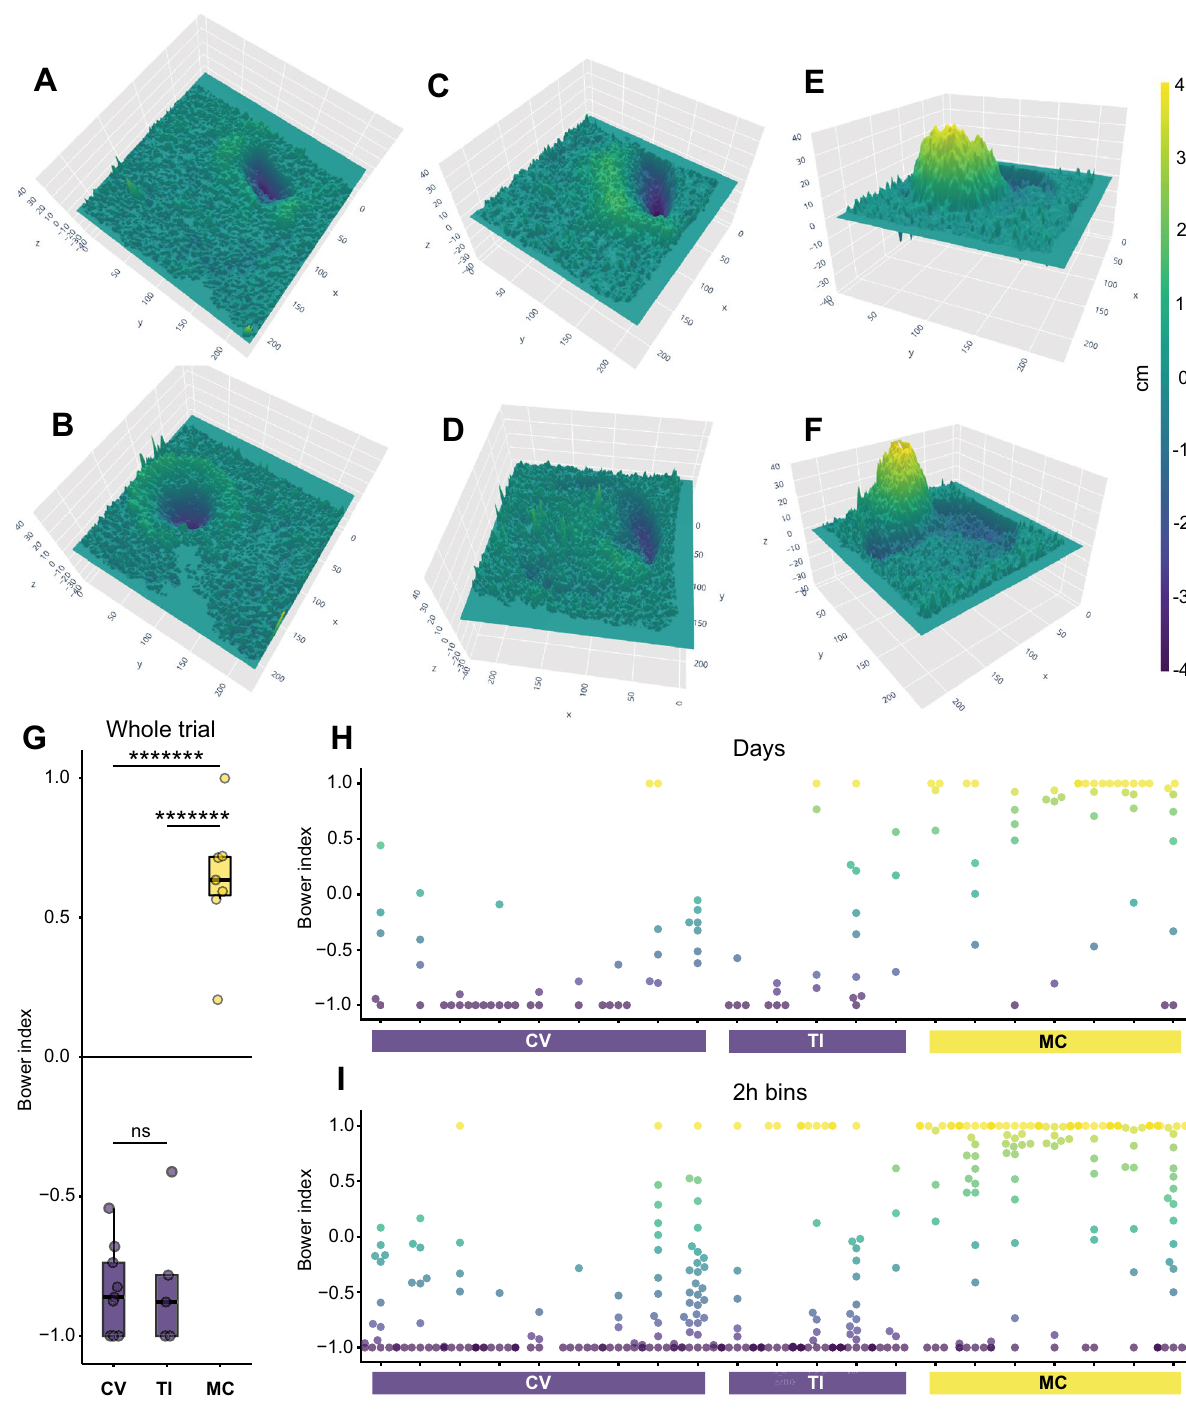
Figure 3. Depth sensing reveals natural species differences in bower construction at multiple timescales. Representative 3D reconstructions show pits constructed by Copadichromis virginalis (CV, n = 9; ( A , B )), pits constructed by Tramitichromis intermedius (TI, n = 5; ( C , D )), and castles by Mchenga conophoros (MC, n = 7; ( E , F )); all z-axes amplified for visual effect). The Bower Index, a measure of the directional bias in bower construction, revealed strong species differences in final bower structure (whole trial change, e.g. ( A – F )). MC exhibited a positive bias (extreme depth change regions tended to be elevated) and differed strongly from both TI and CV, which exhibited negative biases and did not differ significantly from each other ( G ). Strong species differences in structural development were also present when depth data was analyzed at daily ( H ) and hourly (I, 2-h bins) timescales, mirroring the direction of differences observed for whole trial change. Each point represents the observed Bower Index for a single time bin within one trial. Different individuals are separated into columns along the x-axis, grouped by species. The color of each point reflects the Bower Index for that time bin (− 1, purple, representing pure pit-like depth change; 1, yellow, representing pure castle-like depth